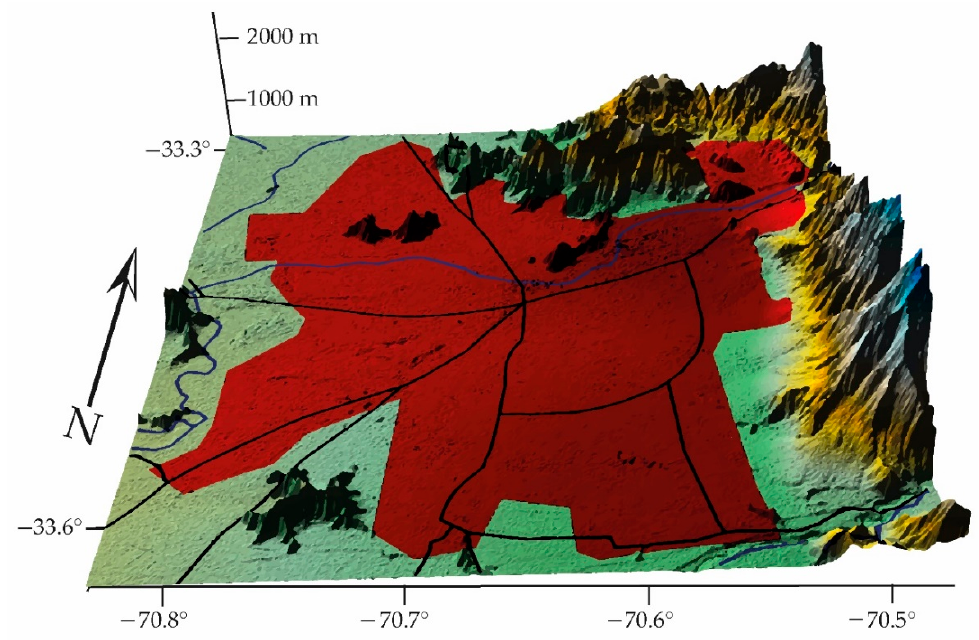
Figure 9. C K, Pudahuel = 0.98, the influence of the entropy of the contaminants is greater (Geographic coordinate system (GCS), World geodetic system 1984 (WGS84)).